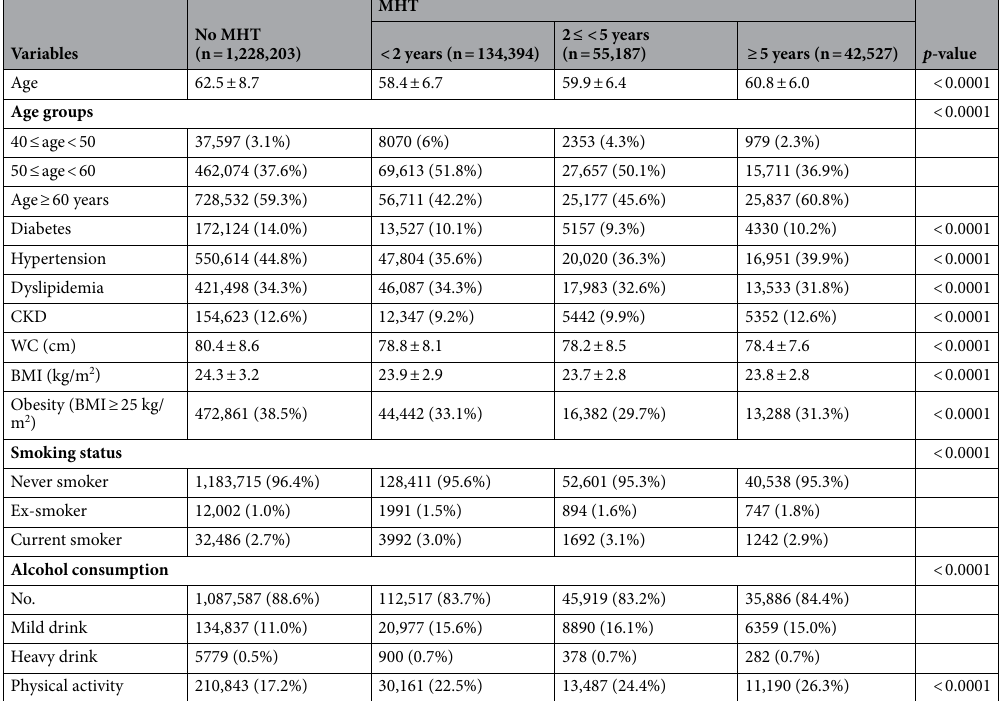
Table 1. Baseline characteristics of the study populations according to history of MHT. BMI body mass index, CKD chronic kidney disease, MHT menopausal hormone therapy, WC waist circumference. P < 0.05 indicates a significant difference among groups by